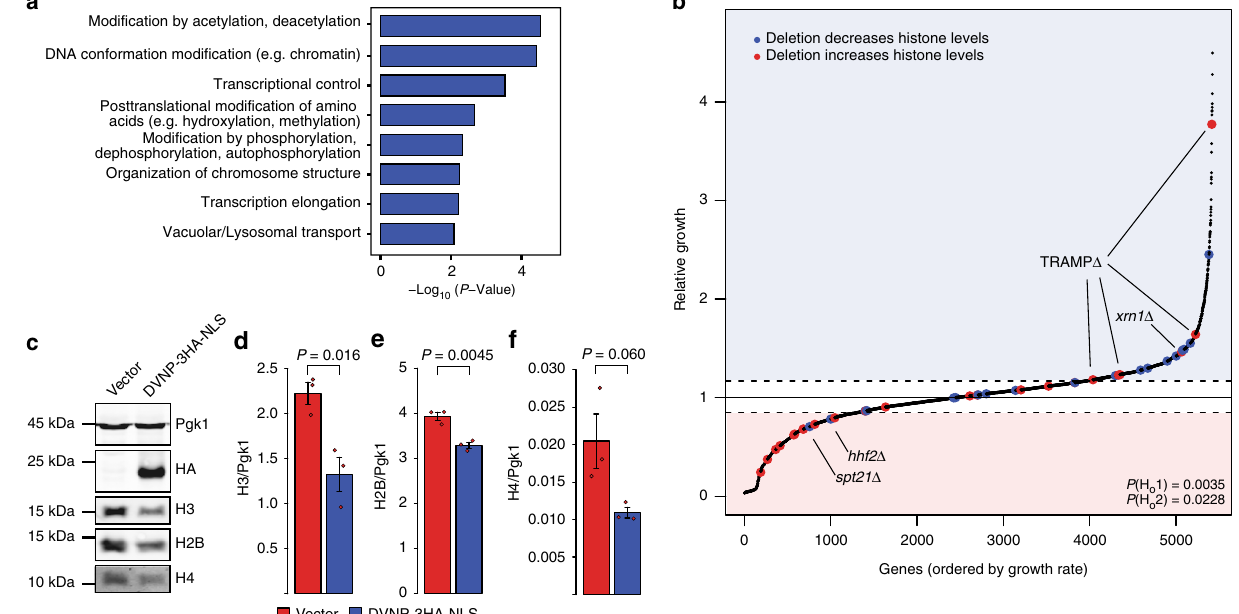
Fig. 4 Histone loss is an adaptive response to DVNP toxicity in S. cerevisiae . a Signi fi cant MIPS functional classi fi cations of gene deletions that relieved DVNP toxicity in the SGA screen. b Relative growth of ~5500 non-essential deletion strains expressing DVNP-3HA-NLS from a GAL1 promoter. Gene deletions known to increase and decrease histone expression are shown in red and blue, respectively. Two null hypotheses were rejected by χ 2 test: H o 1: gene deletions that affect histone levels are randomly distributed and, H o 2: gene deletions that increase and decrease histones are enriched below and above the growth thresholds by chance. Dashed lines denote positive and negative growth thresholds. Exceptions to the trend have been labeled. See Supplementary Data 1 for a full list of genes. c Immunoblot of total protein extracts from DVNP-3HA-NLS-expressing and control cells. d – f Quanti fi ed immunoblots showing histone levels in DVNP-3HA-NLS-expressing and control cells ( n = 3 biological replicates). Histone signal was normalized to the loading control, Pgk1, which remained constant between conditions. These experiments were repeated three times with similar results. P -values were obtained by two sided Welch ’ s t -test. Error bars represent the standard error of the mean (SEM)